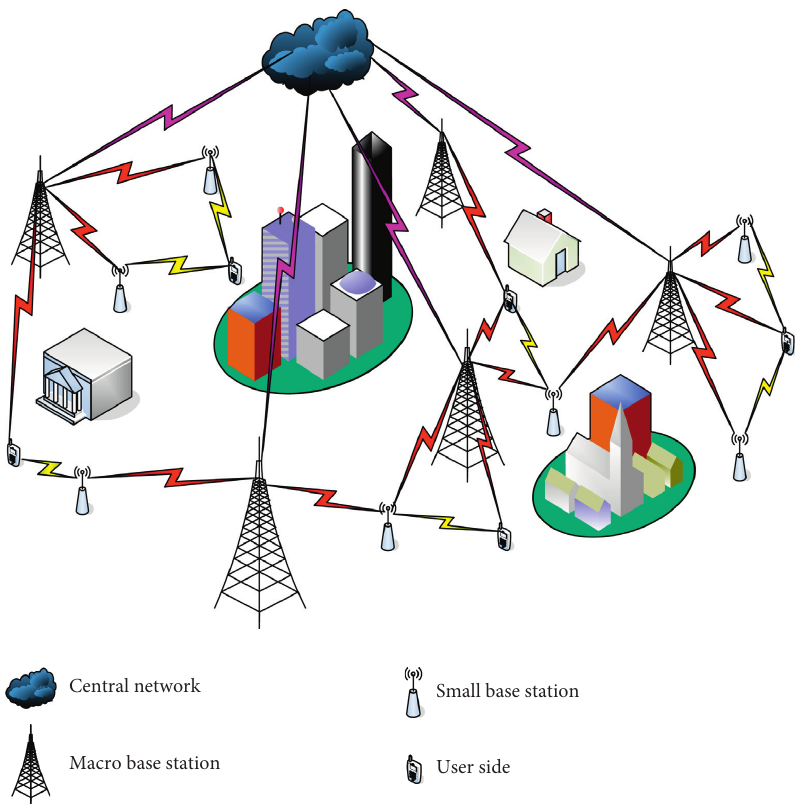
Figure 3: Schematic diagram of DCN networking